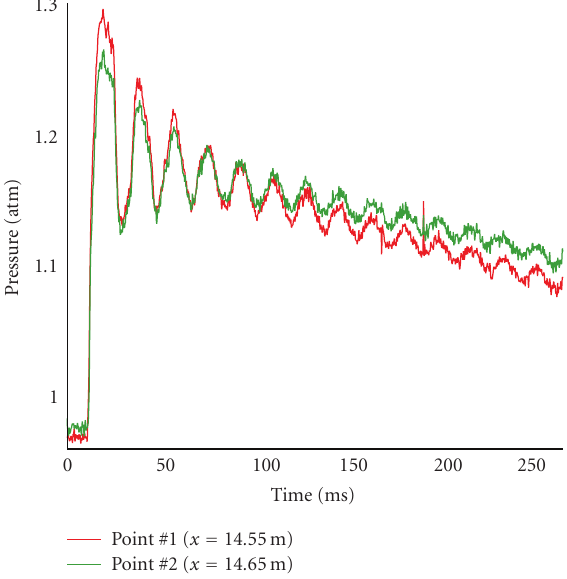
Figure 14: Pressure measurement (HTPB slab @ AOA = 0 ◦